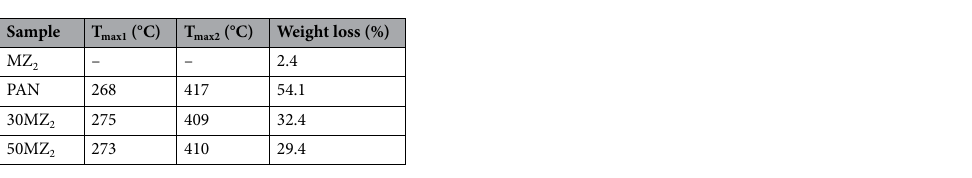
Table 1. Data obtained from TGA and DTA curve of MZ 2 , PAN, 30MZ 2 and 50MZ 2 .